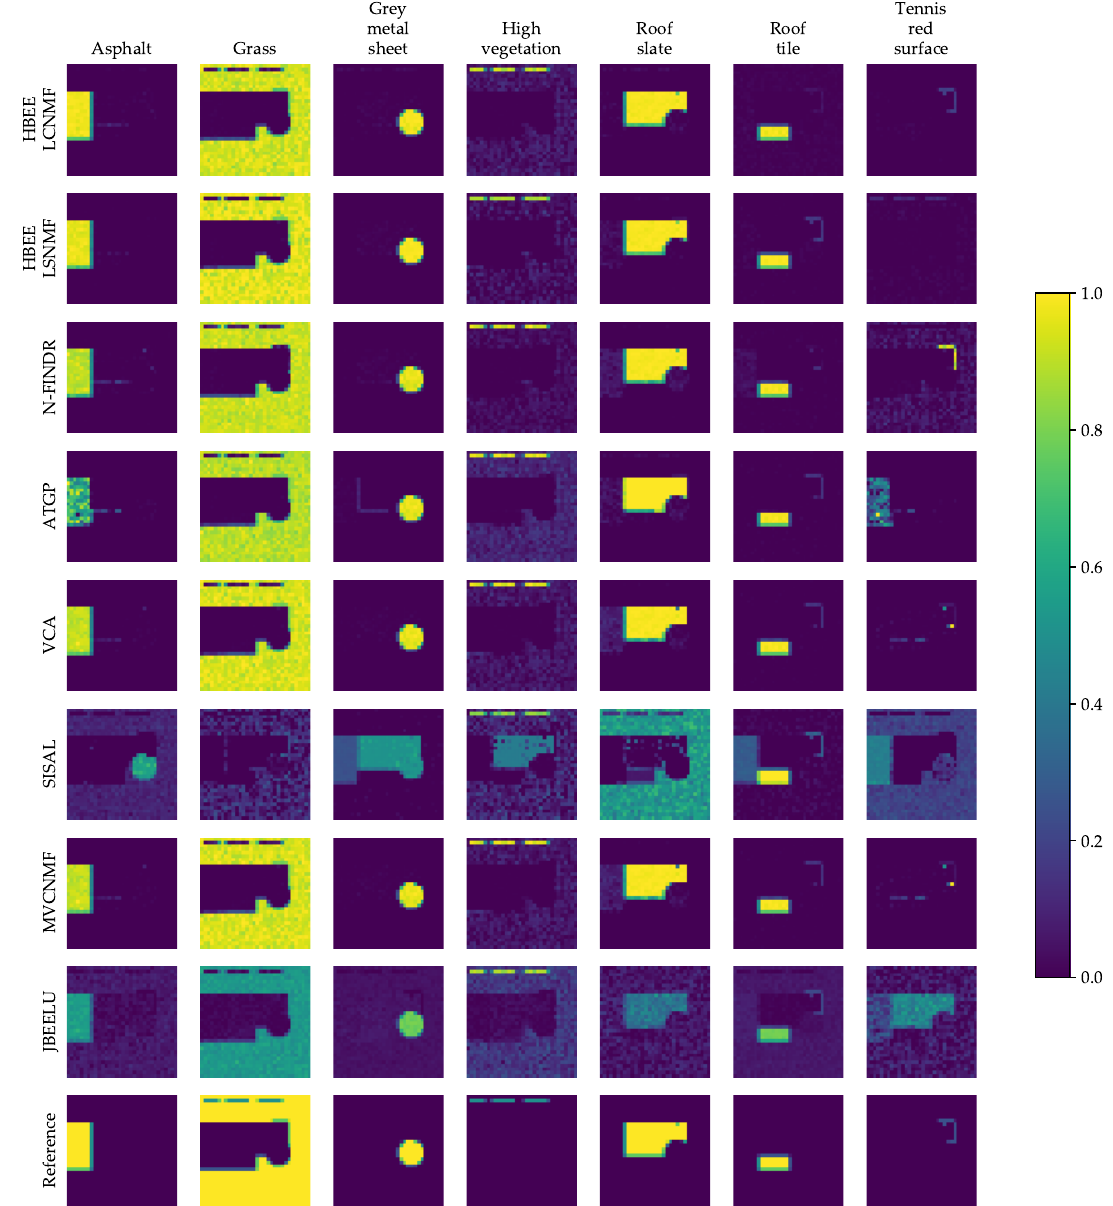
Figure 12. Abundance fractions of the seven endmembers (column) estimated with different unmixing methods (row) from the synthetic image, based on the SAM estimate-reference spectrum couples.